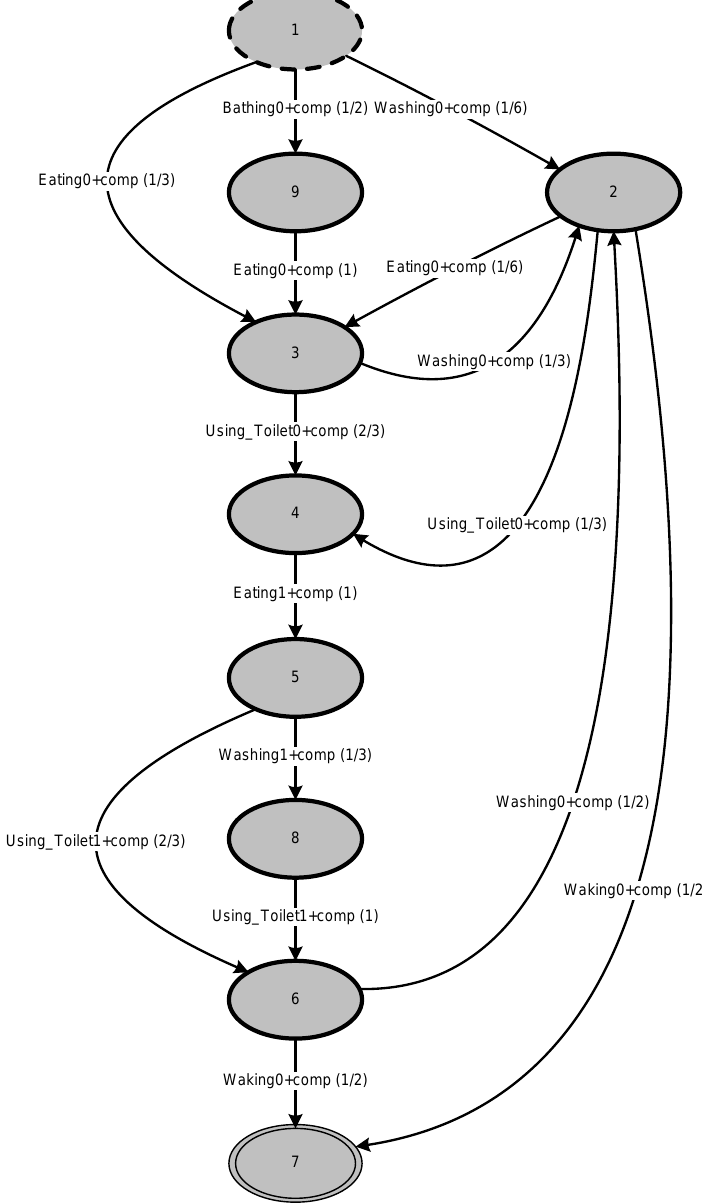
Figure 6. Typical behavior mined from the example event log in Table 1 using the Transition System Miner (TSM) with starting state 1 and final state 7; arcs labeled with activity names and probabilities (in